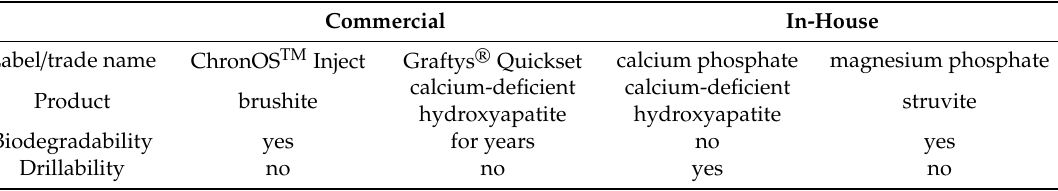
Table 1. Bone cements; overview of the commercial and in-house-prepared cement systems used for biomechanical analysis in this